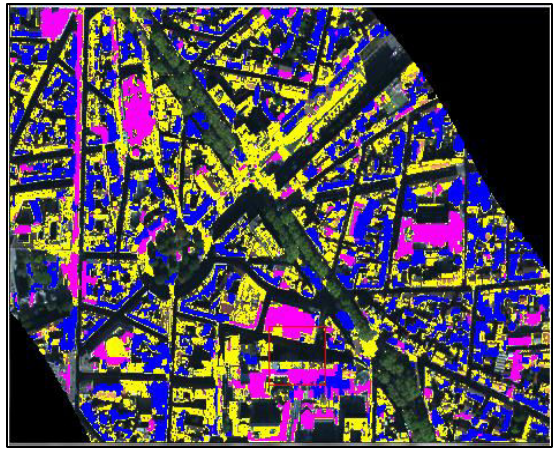
Figure 10. Identification of the socio-economic functions of buildings based on their morpho-spectral attributes: shopping mall/parking's (magenta), cultural/religious/administrative building (yellow), residential/professional building